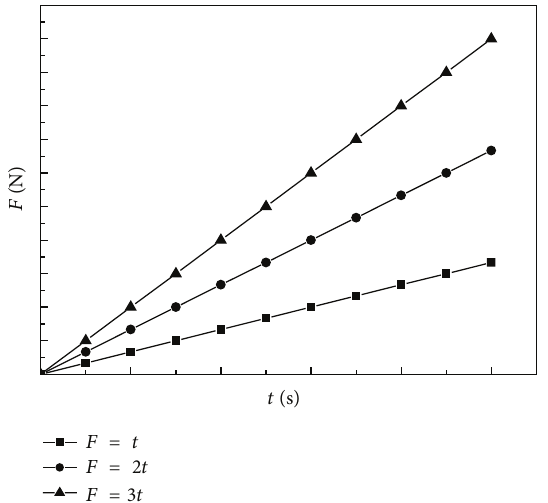
Figure 5: The load spectrum adopted in numerical